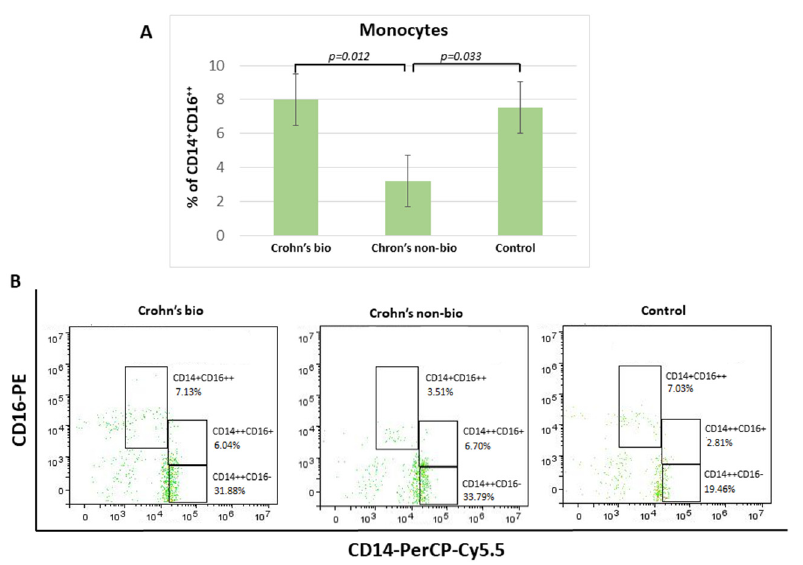
Figure 2. Percentage of monocyte subpopulations (CD14 ++ CD16 − , CD14 + CD16 ++ , and CD14 ++ CD16 + ) in patients with IBD . Statistical histograms ( A ) and representative dot plots ( B ) of patients treated with biological and non-biological therapy as well as of control subjects. p <